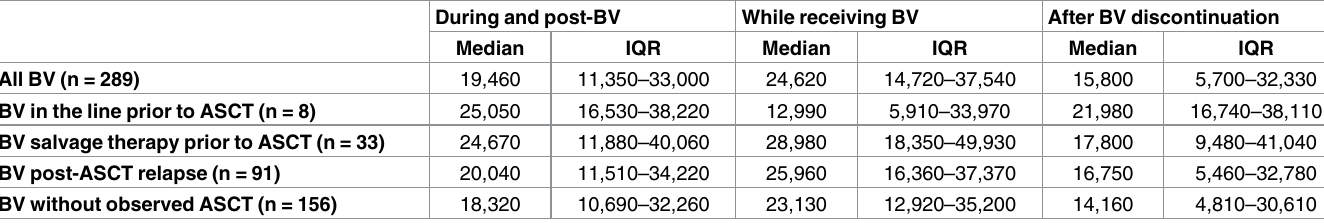
Table 2. Median (IQR) monthly all-cause costs (USD), according to timing with respectto BV